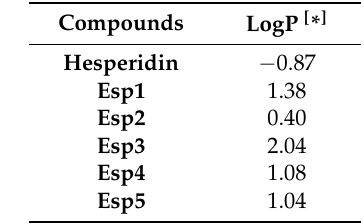
Table 3. LogP values of hesperidin and its synthetic